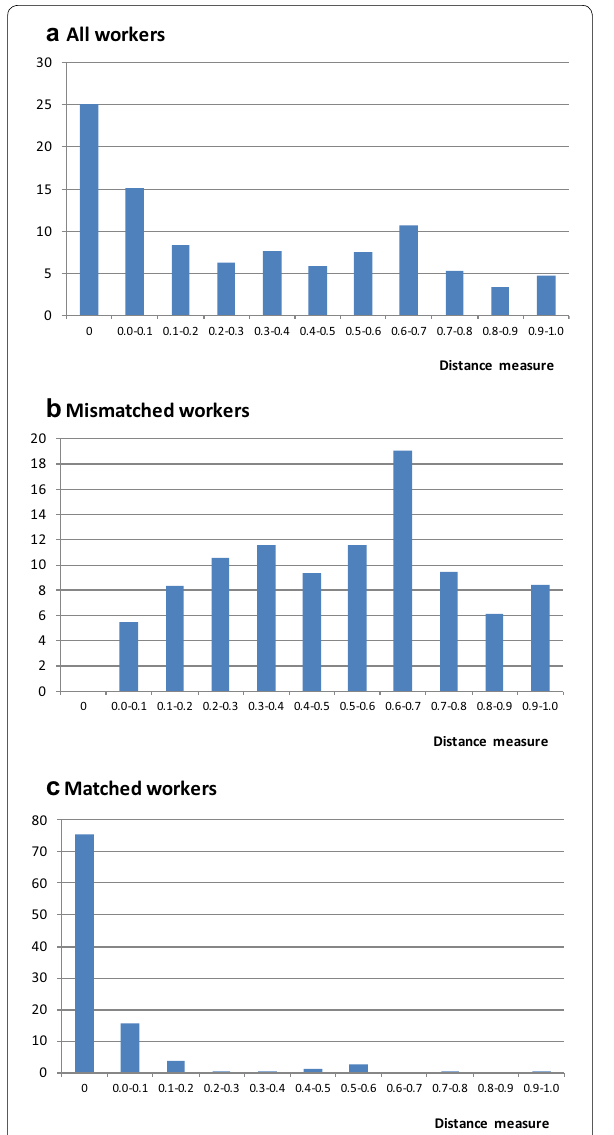
Fig. 1 Distribution of workers across the distance measure between field of study and occupation. The sample comprises employed individuals with a bachelor’s degree, aged between 25 and 60 years. Source: the 2010 Brazilian census